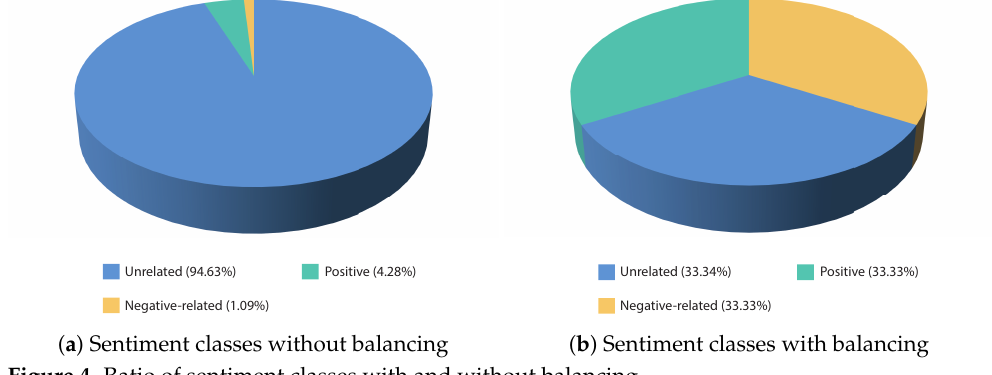
Figure 4. Ratio of sentiment classes with and without balancing. Table 4. The number of instances for each class after SMOTE, ROS